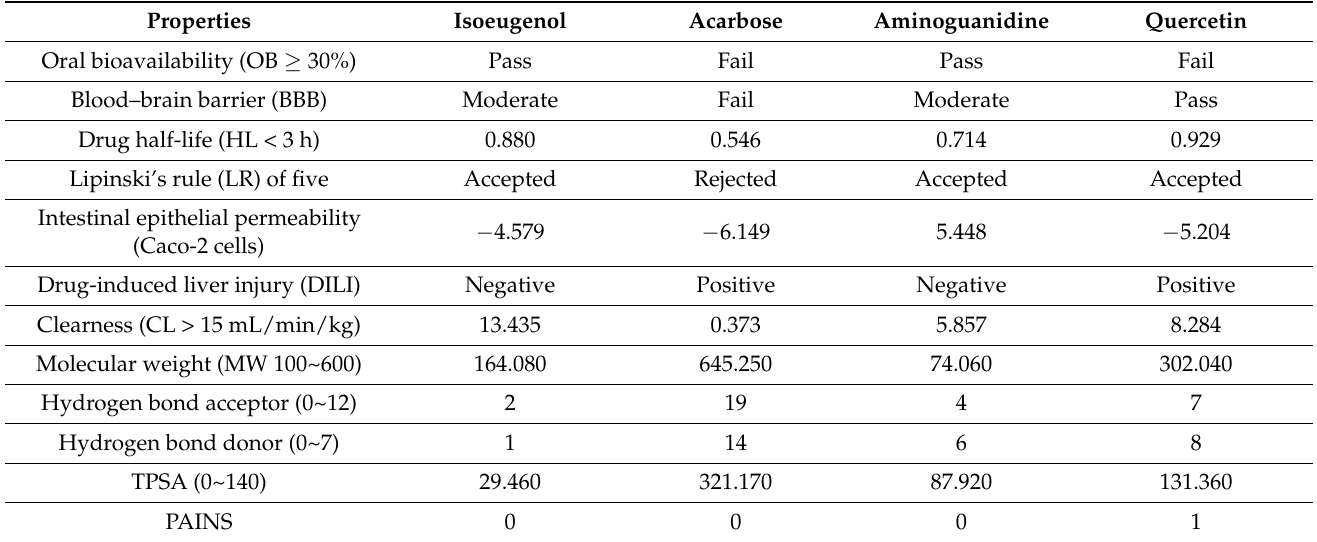
Table 9. Druglikeness and pharmacokinetic properties of the representative compounds.